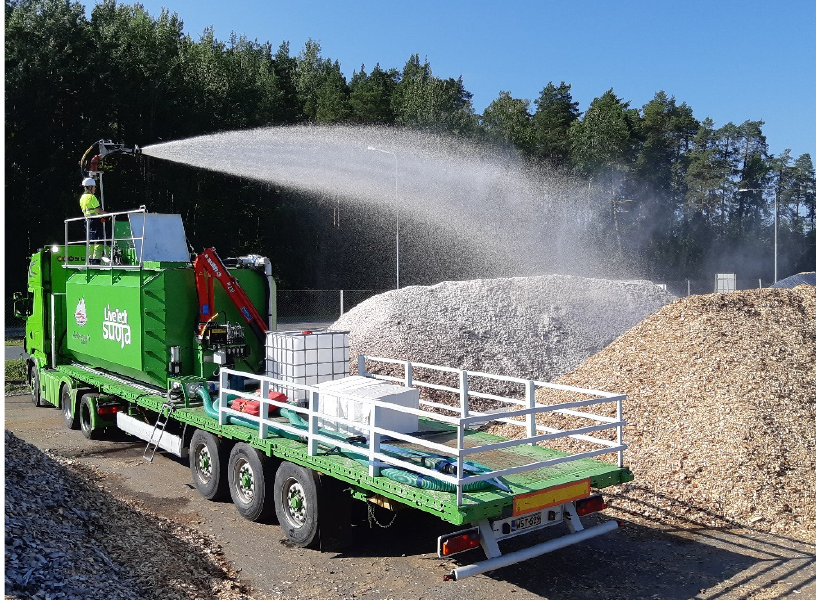
Figure 1. Cover of two experimental piles with the innovative Livetech Suoja ® material using a specially designed truck at the experimental site. Source: Luke/Robert Prinz. Six piles of stemwood chips were established at Kuopio Energia’s premises (Figure 2). Livetech Suoja ® method (abbreviation used: bio-pile cover).